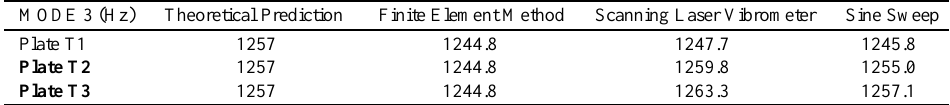
Table 1 Theoretical and Experimental Mode 3 Natural Frequencies (Hz) for the Uncoated Plates w/out Strain Gages